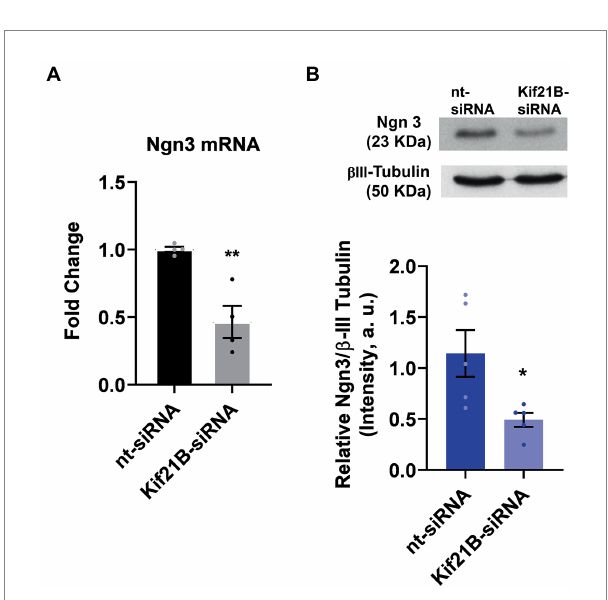
FIGURE 6 Kif21B silencing downregulates Ngn3 expression. (A) Kif21B-siRNA reduces Ngn3 mRNA levels in hippocampal neuron cultures; N = 4. (B) Ngn3 protein levels in electroporated cultures with Kif21B-siRNA, evaluated by western blot using β III-tubulin as a loading control; N = 5. Graphs represent quantitative analysis expressed as mean ± SEM; Unpaired t -test: * p < 0.05, ** p < 0.01 vs. nt-siRNA